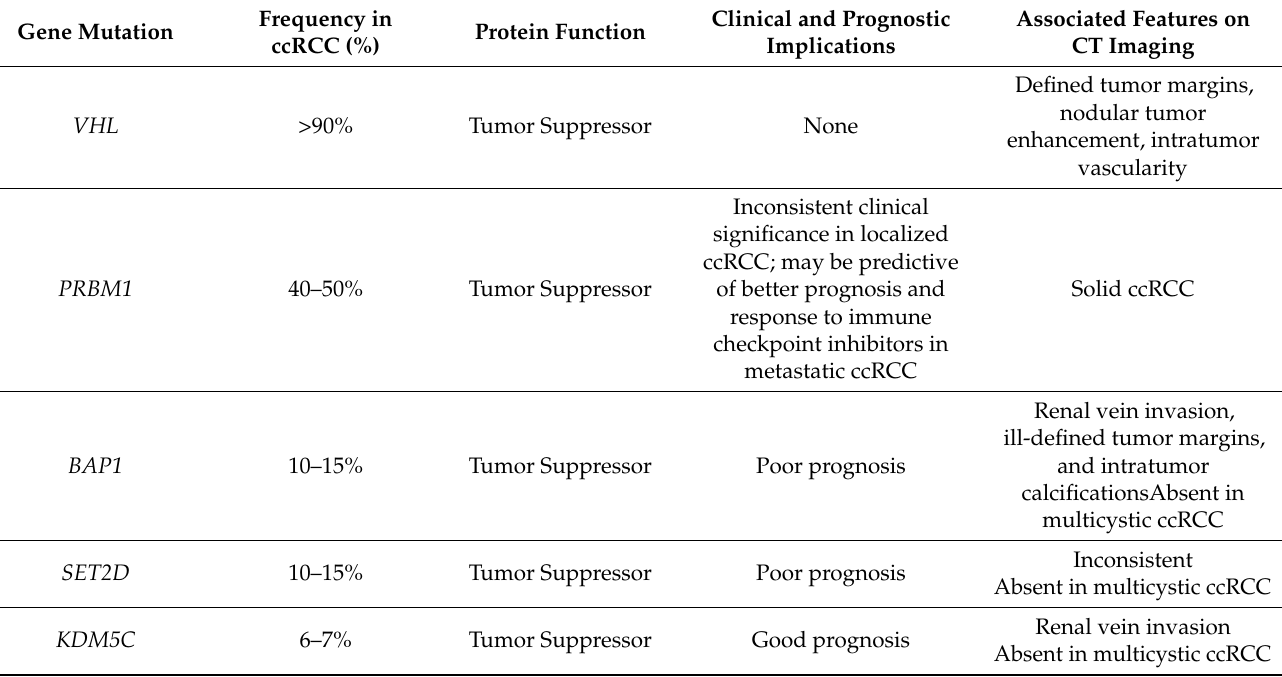
Table 2. Summary of the top 5 most common gene mutations in